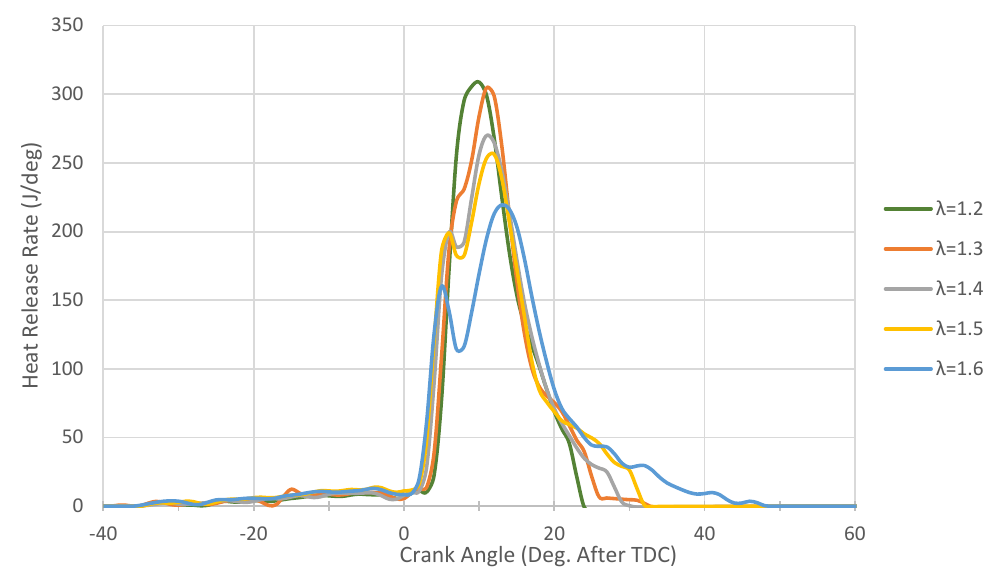
Figure 13. Heat release rate versus crank angle (SOI = 9 ◦ BTDC). λ , excess air ratio.